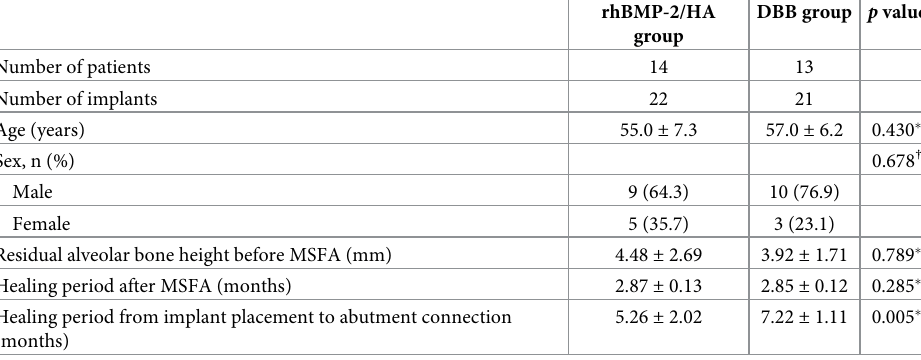
Table 1. Demographics and clinical characteristics of the patients included in this